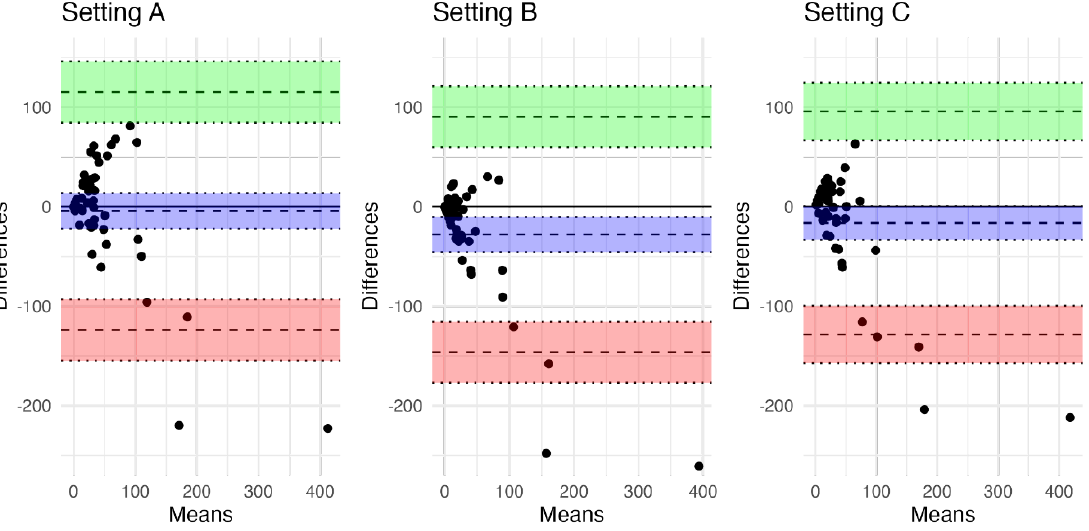
Figure 2. Bland–Altman plots comparing ischemic core volume on CT perfusion for each setting and the final infarct volume on magnetic resonance imaging follow-up. Shaded areas represent 95% confidence intervals for the upper/lower limit of agreement (green/red) and for bias (blue).